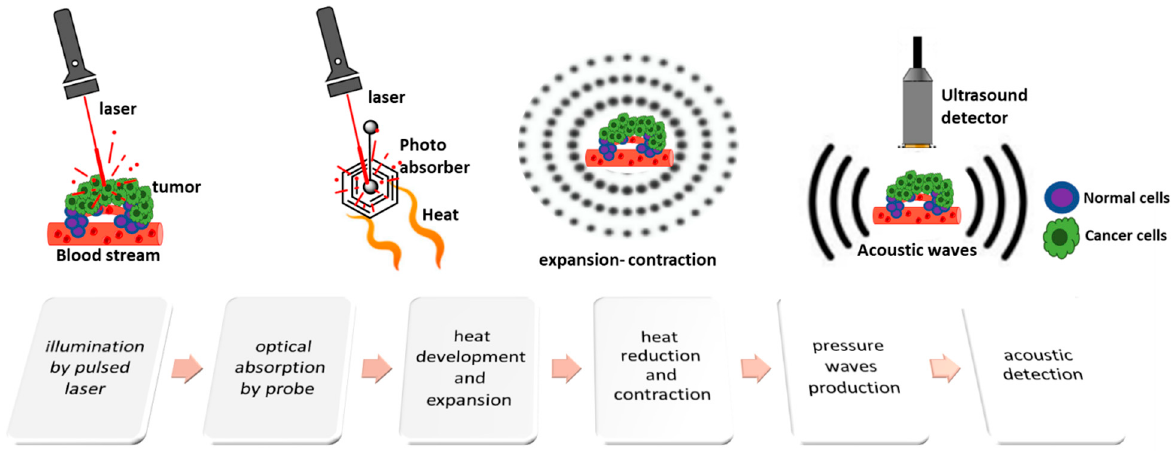
Figure 2. Schematic representation of the basic principles of photoacoustic imaging. The tissue with cancer cells (green cells) is irradiated with pulsed electromagnetic radiation, which is absorbed by a photo absorber, to produce sound waves that are detected by a focused ultrasonic transducer.